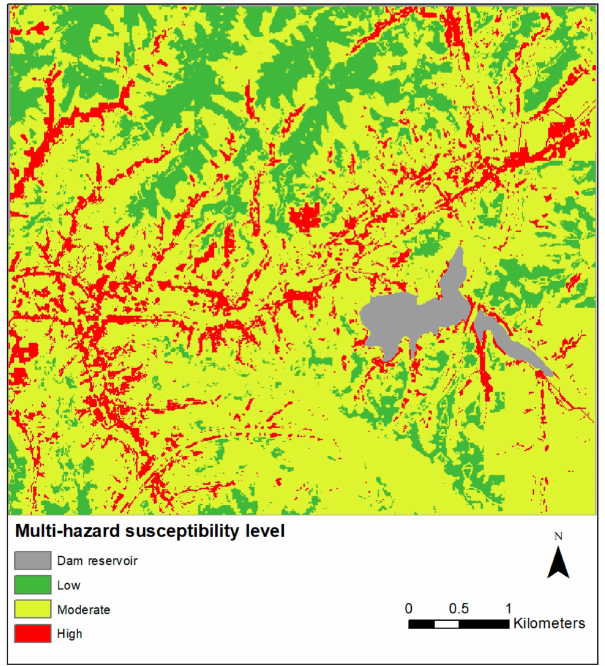
Figure 18. Multi-hazard susceptibility level map of the study